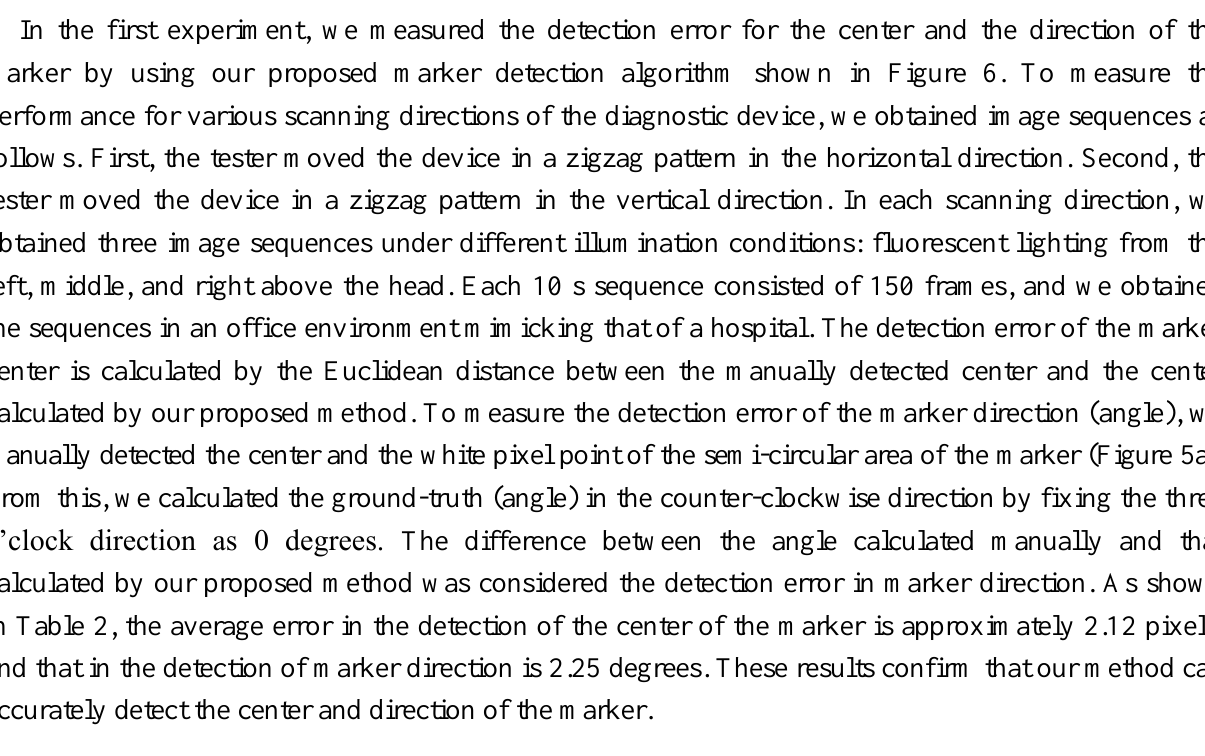
Table 2. Detection error results for distance and angle of marker center pixel.